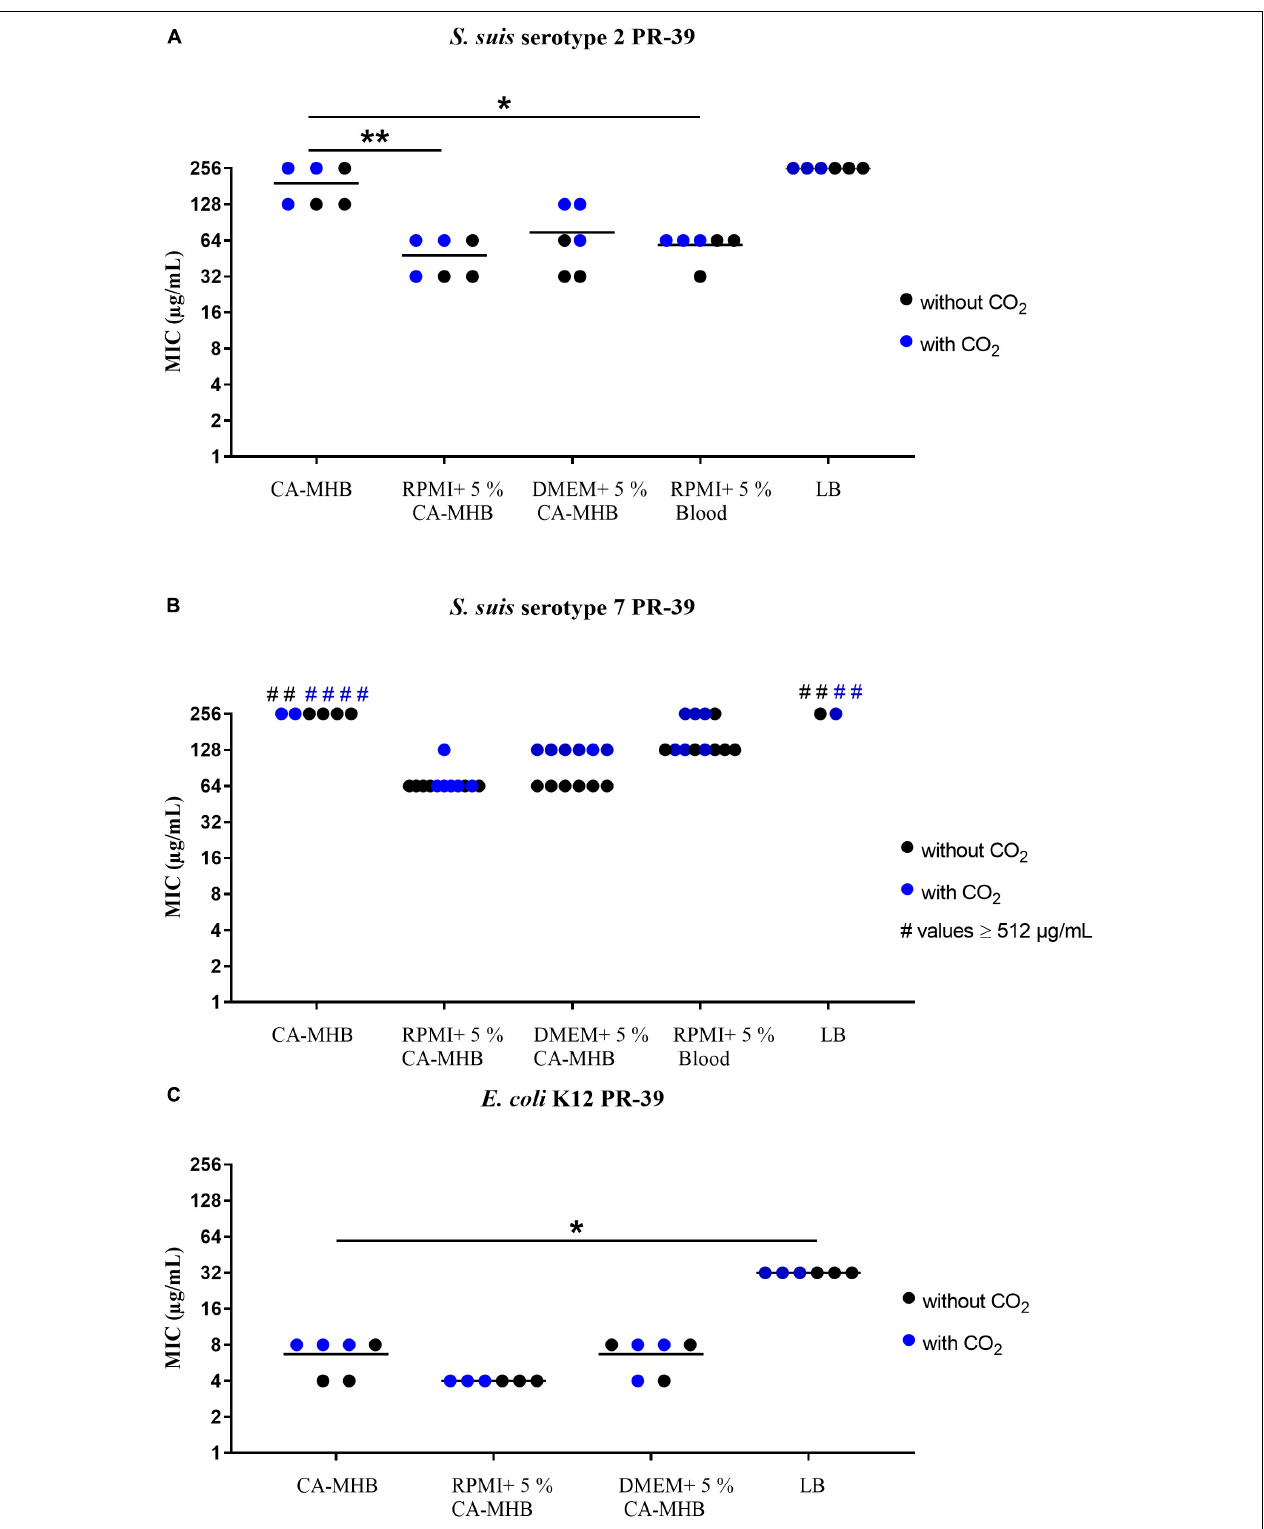
FIGURE 2 | MIC testing with PR-39 in accordance with CLSI recommendations by broth microdilution in different media (data shown are values from three independent experiments). (A) S. suis serotype 2, (B) S. suis serotype 7, and (C) E. coli K12 against PR-39. Statistics: Kruskal–Wallis test with subsequent Dunn’s comparisons test ∗ p < 0.0332, ∗∗ p <